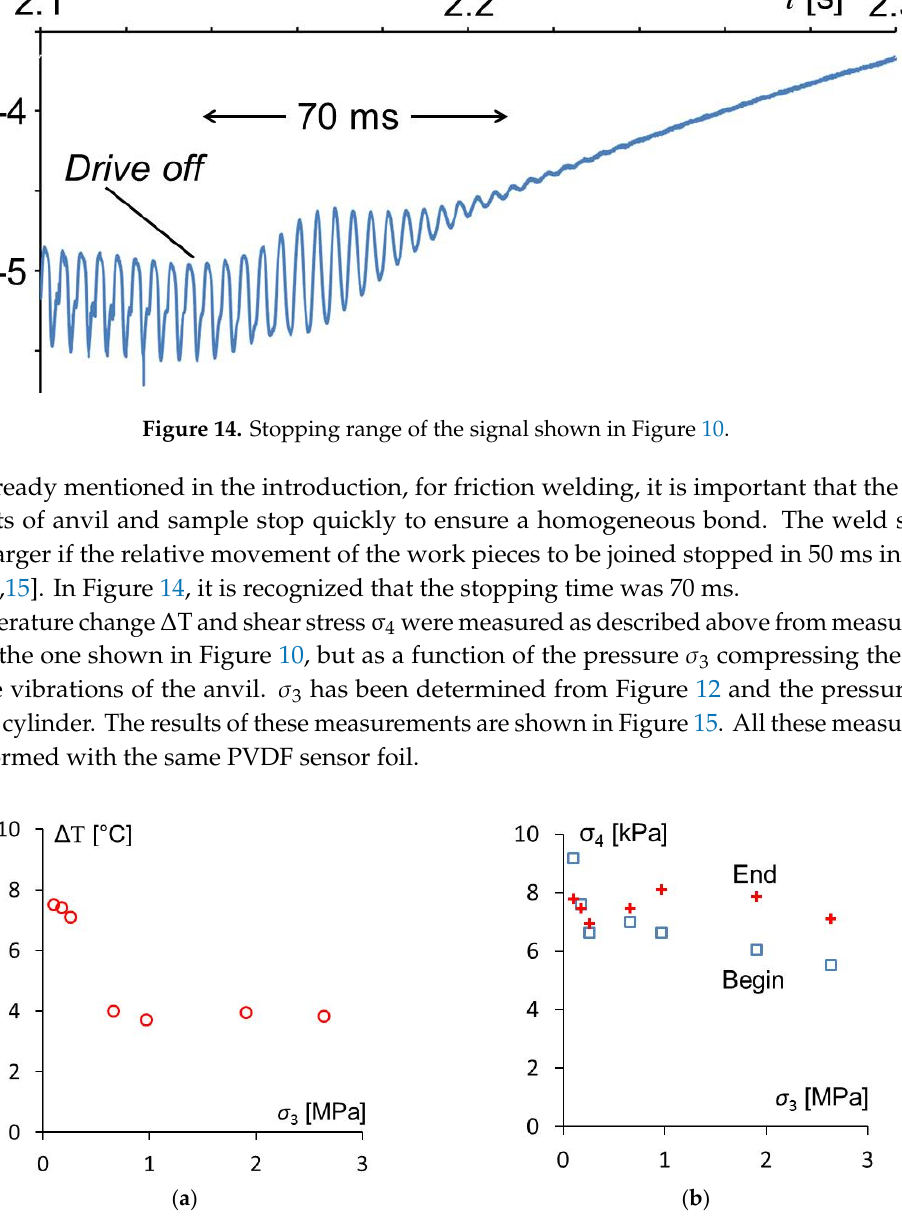
( b ) Figure 16. Temperature rise Δ T ( a ) and shear stress σ 4 ( b ) as a function of the amplitude A of the linear vibrations of the friction welding machine. 3.2. Circular Friction Welding Machine Shear stress and temperature change were also measured of a circular friction welding process performed with the machine ZMT 2.0 from Fischer Schweißtechnik (Berkatal, Germany). Figure 17 shows the setup of this experiment. A lower holder was mounted on an anvil. In this holder, there a square PETG plate, 200 mm and 4 mm in edge length and thickness, respectively, was fixed. A PVDF